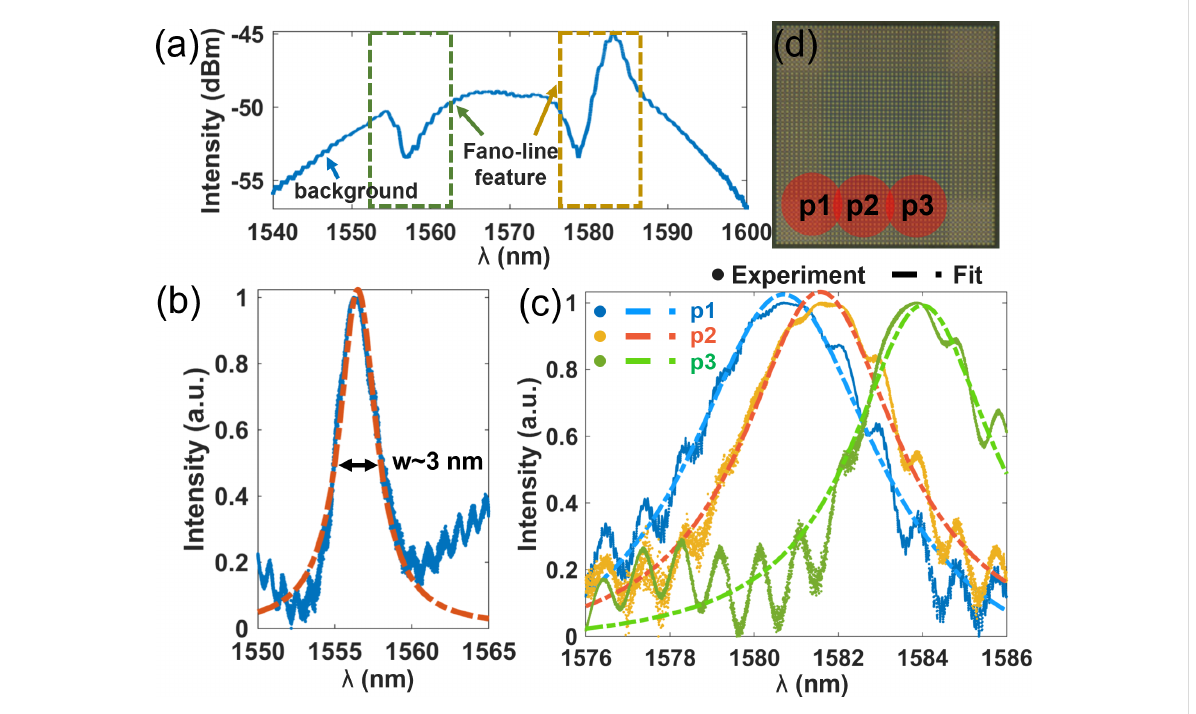
Figure 4: Measurement results. (a) Scattering spectrum over a wide range of wavelengths. (b, c) Resonances observed around 1555 and 1582 nm respectively. Measured data and Lorentzian fittings are shown as dots and dashed lines, respectively. High intensity is used to identify the resonance wavelength in the measurement of (a). (d) Illumination spot positions p1, p2, and p3, which excite the resonances in (c). Fano-line features are ob- served due to the interference between the designed resonance and direct reflection from the substrate in the measurement of (a). Low intensity and precise illumination position adjustment were applied in the measurements of (b) and